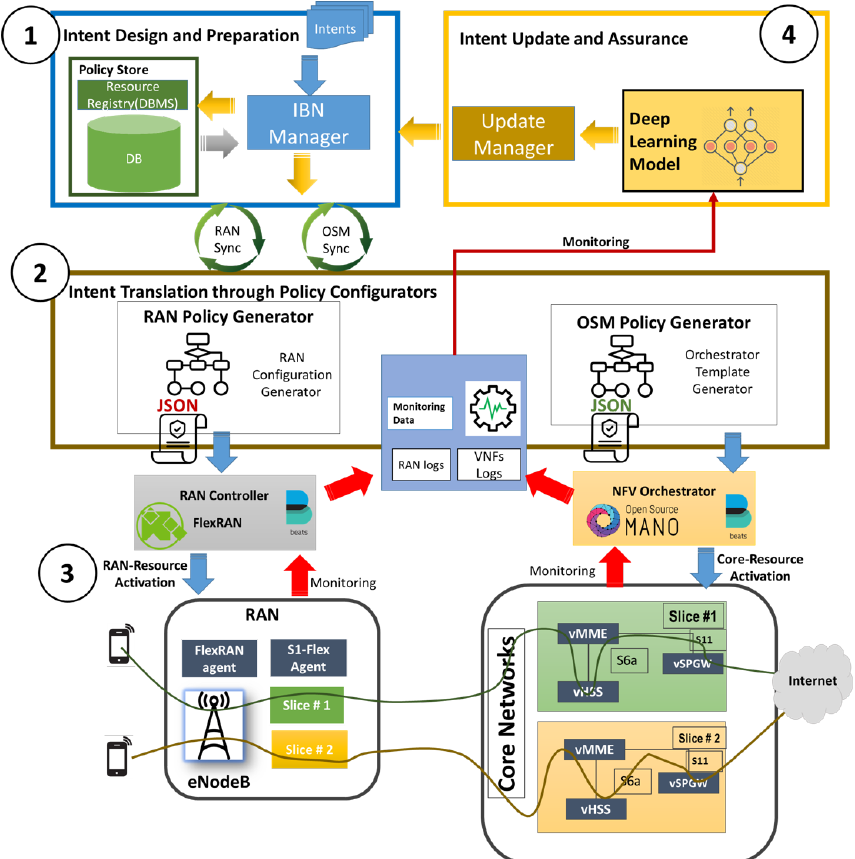
Figure 3. End to End network slicing architecture with intent-based